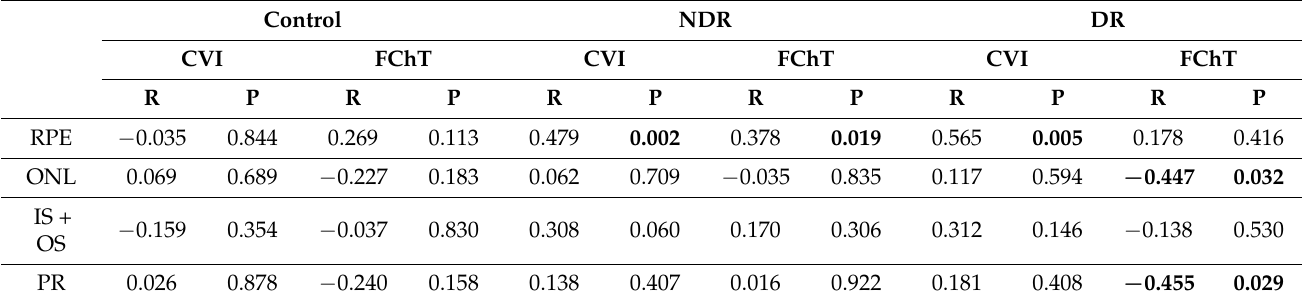
Table 8. Correlations between retinal layer thickness and choroidal parameters among study groups.